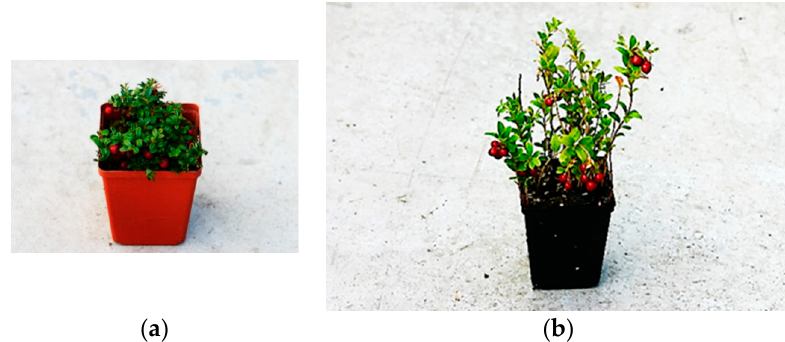
Figure 1. Greenhouse grown lingonberry plants. ( a ) Vaccinium vitis-idaea ssp. minus ; ( b ) V. vitis-idaea ssp. vitis-idaea . Table 1. Differences between the two subspecies of Vaccinium vitis-idaea .